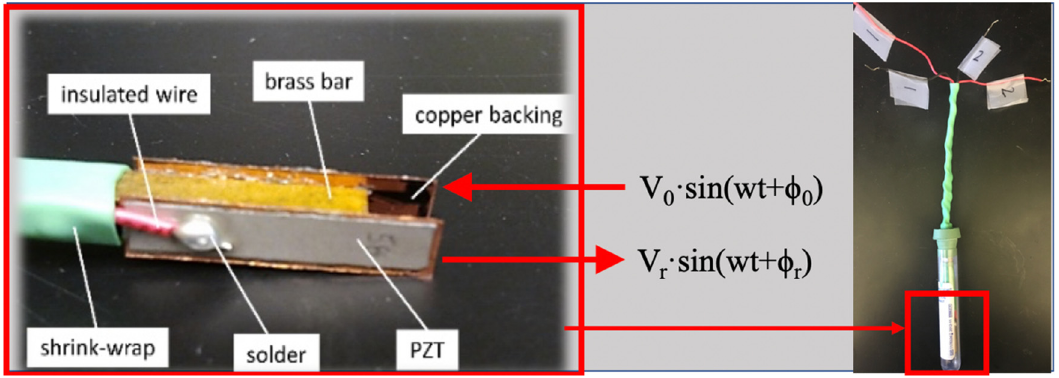
Figure 1. Probe construction and operation.